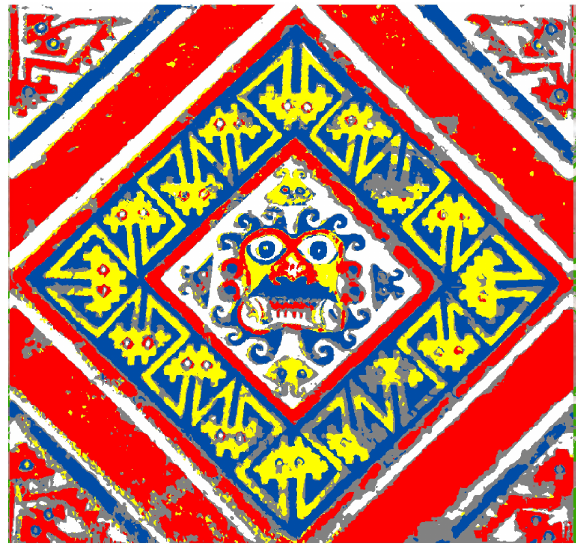
Figure 4. Per pixel thematic map obtained from the combined use of ortho-rectified image and DSM of the 2006 image.